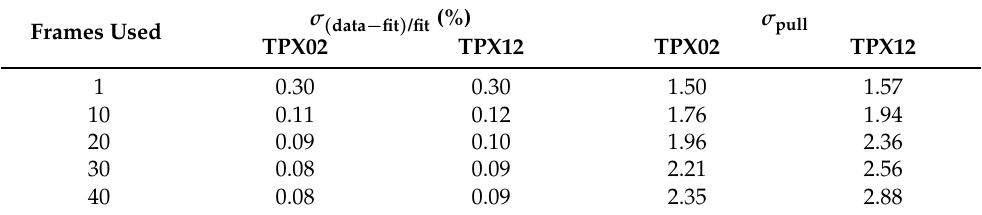
Figure 40. Pull distribution defined as (data-fit)/ σ data , where σ data = The data are averaged over layers 1 and 2 for TPX02 and TPX12 with 10 frames (1s each) combined. The data shown in Figure 39 are used. LHC fill 4449. Taken from Ref. [14]. Table 17. Precision of TPX02 and TPX12 luminosity measurements with respect to the fitted curve for the average of layers 1 and 2. The precision is given for 1 frame and for 10, 20, 30 and 40 frames combined. The width of the Gaussian fit σ ( data − fit ) /fit gives the precision of the measurement and σ pull gives the width of the fit of the pull distribution with statistical uncertainties only. LHC fill 4449. Taken from Ref.